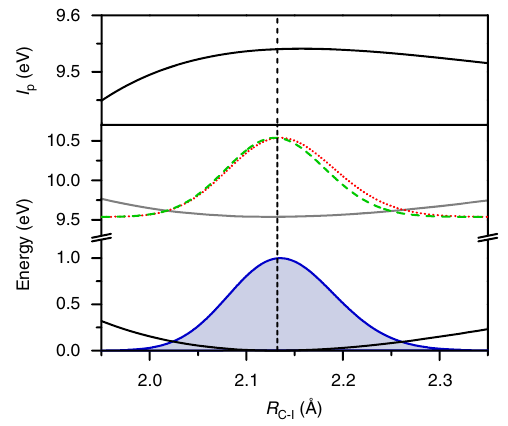
Fig. 3 Launching of sub-picometer scale C – I stretching motion in CH 3 I + . The vertical ionization potential I p of CH 3 I as a function of C – I bond distance ( top panel ), as obtained from the energy gap between the Morse potentials of CH 3 I ( solid black line ) and CH 3 I + ( solid gray line ) along the C – I stretch coordinate ( bottom panel ). The spectroscopic parameters used to construct the potentials are given in Supplementary Note 6. The vertical dashed line denotes the equilibrium C – I bond distance of CH 3 I. The vibrational probability densities for CH 3 I, initially at thermal equilibrium ( solid blue line ), the CH 3 I + fraction produced by ionization ( red dotted line ), and the CH 3 I + v = 0 eigenstate ( green dashed line ) are also